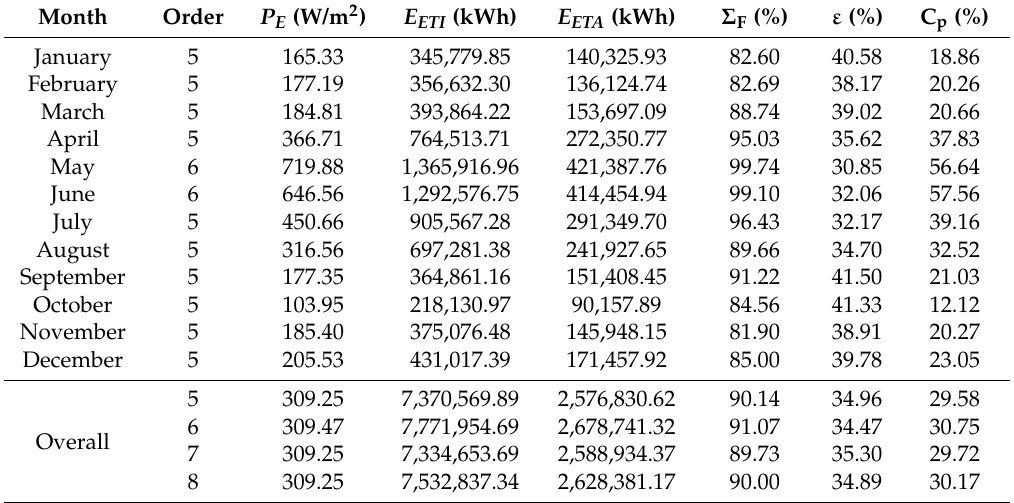
Table 8. Wind energy estimation using MEP-based function for Baburband at 80 m height for